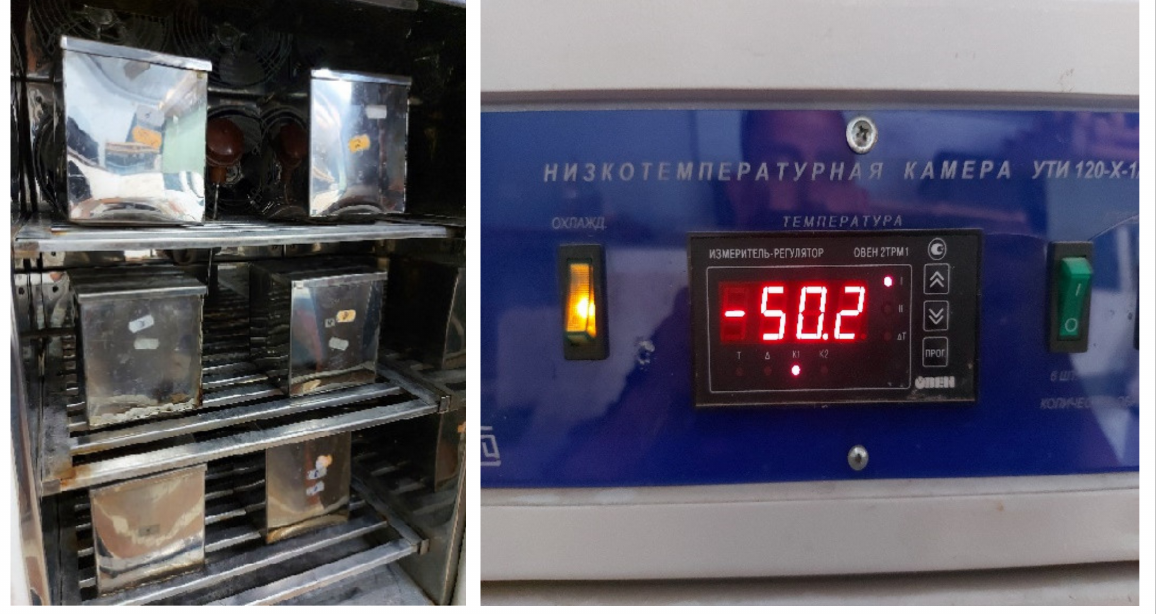
Figure 7. Frost resistance test.